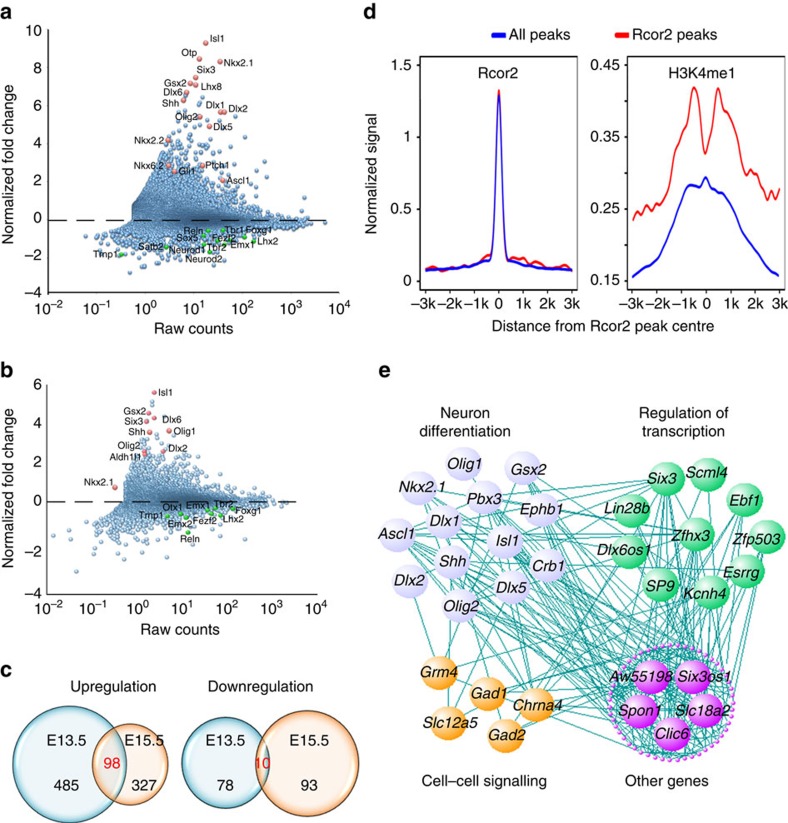
Genome-wide expression changes on Rcor2 depletion in mouse developing cortex by RNA-seq analysis.(a,b) Scatter plot analysis of genome-wide expression profiles of Rcor2cko versus Rcor2fl/fl samples at E13.5 (a) and E15.5 (b). Dots above or below the dash line indicate upregulated or downregulated genes on Rcor2 depletion, respectively. Red dots or green dots highlight the significantly differentially expressed genes on Rcor2 depletion. Raw counts (x axis); gene expression fold changes on Rcor2 depletion (y axis). (c) Venn diagrams of upregulated genes (left) and downregulated genes (right) in Rcor2cko samples compared with Rcor2fl/fl samples. (d) The profiles of Rcor2 and H3k4me1 enrichments analysed in ChIP-seq results shown in Fig. 3 in regulatory regions of genome-wide scale (red) and of the upregulated genes (purple) according to RNA-seq results. (e) Correlation network of overlapped upregulated genes in both E13.5 and E15.5 samples. Lines indicate the correlations between two connected genes with R>0.55. Genes were analysed by GO analysis and divided into different categories.